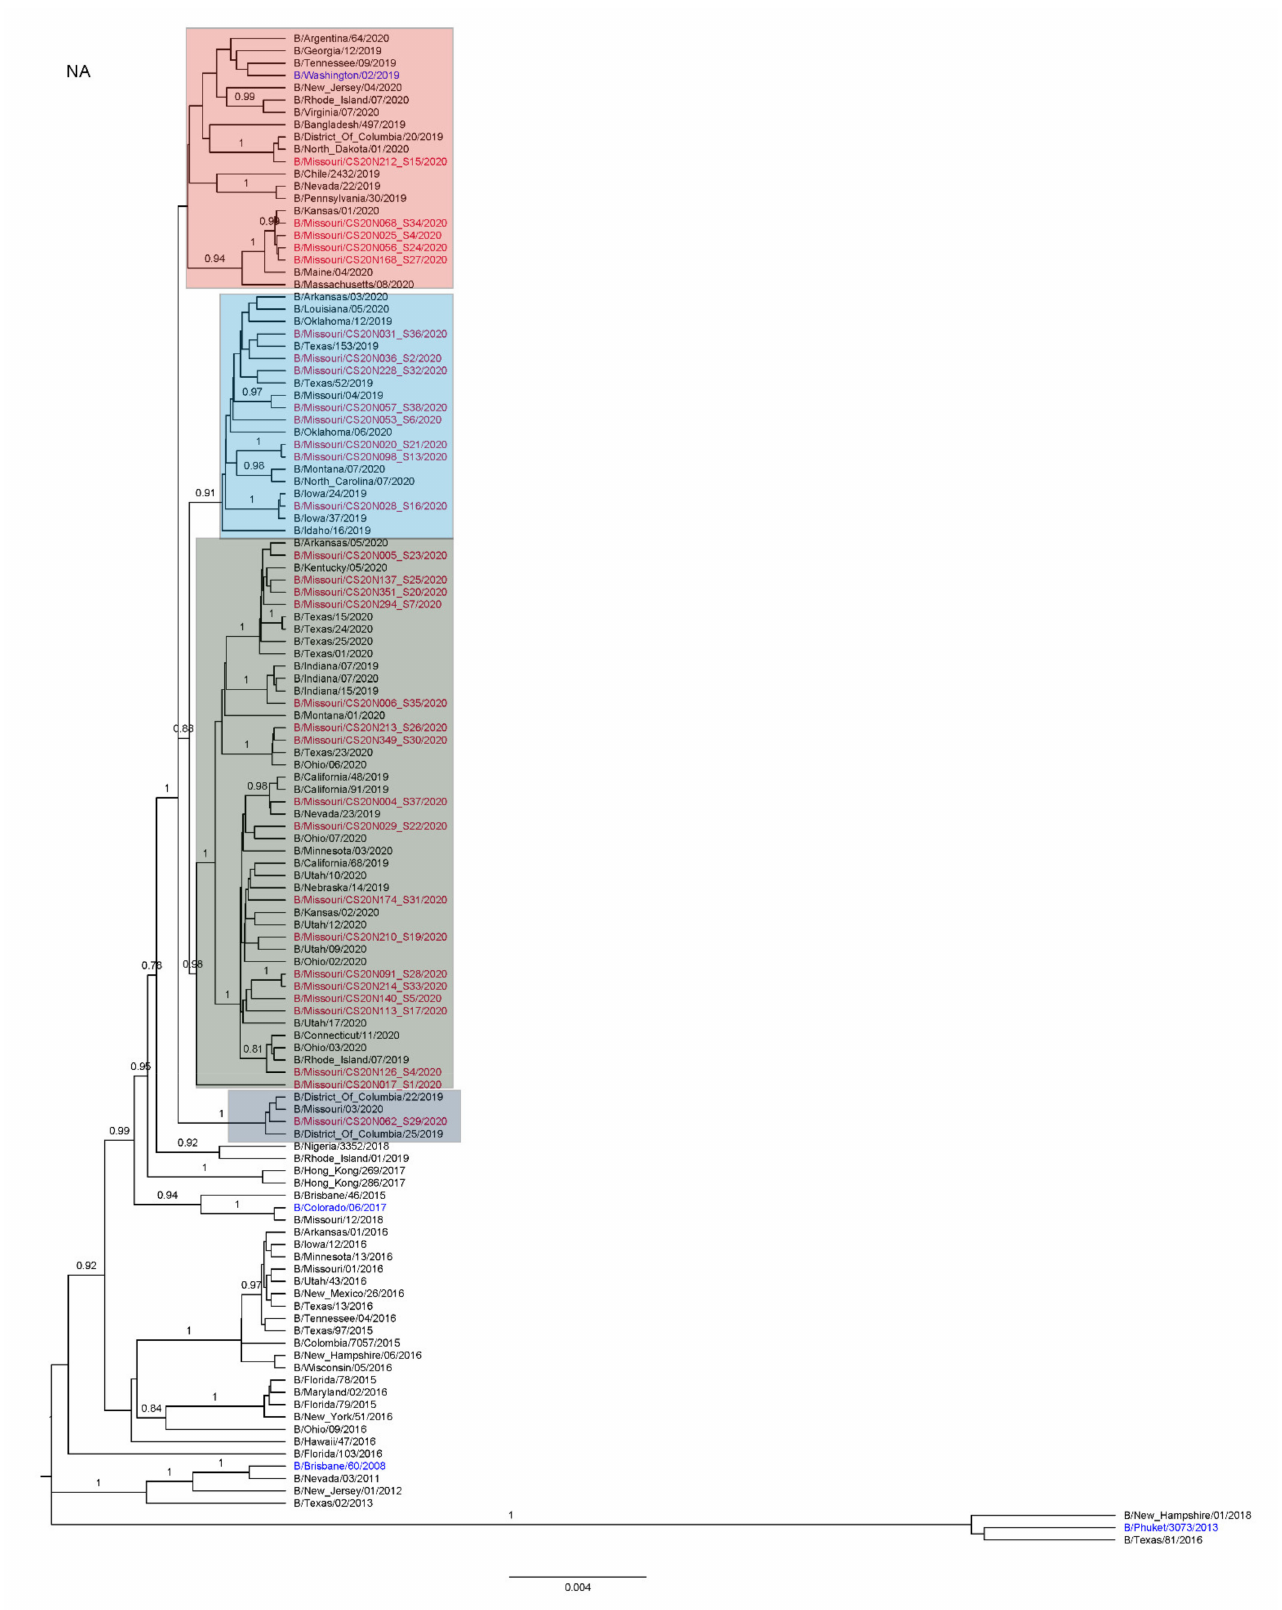
Figure A6. NA Tree. The phylogenetic analyses were performed by using BEAST2 with a Hasegawa–Kishino–Yano (HKY) substitution empirical model, strict clock model, and coalescent constant population prior. Branches with a posterior probability >0.70 were